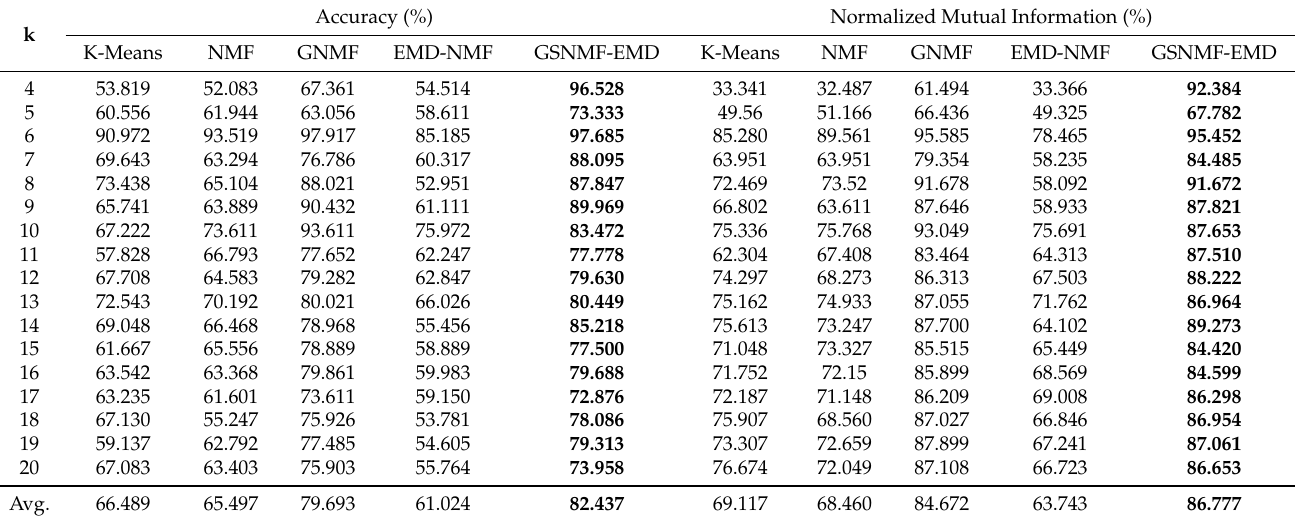
Table 2. Clustering performance on the COIL20 dataset.